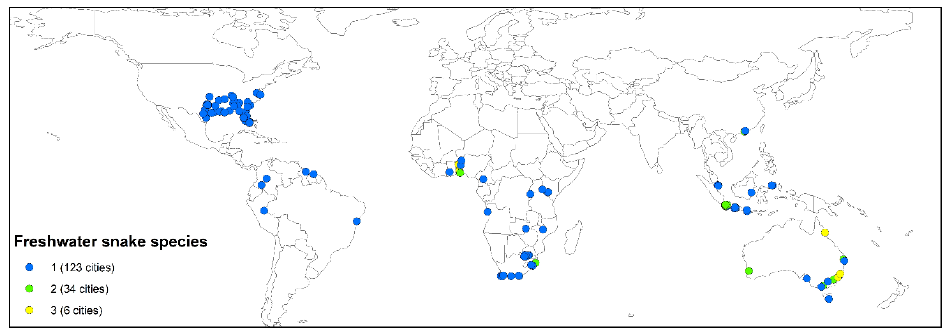
Figure 5. Number of crocodilian species sighted between January 2013 and April 2018 within 50 km of a city with a population of more than 100,000.